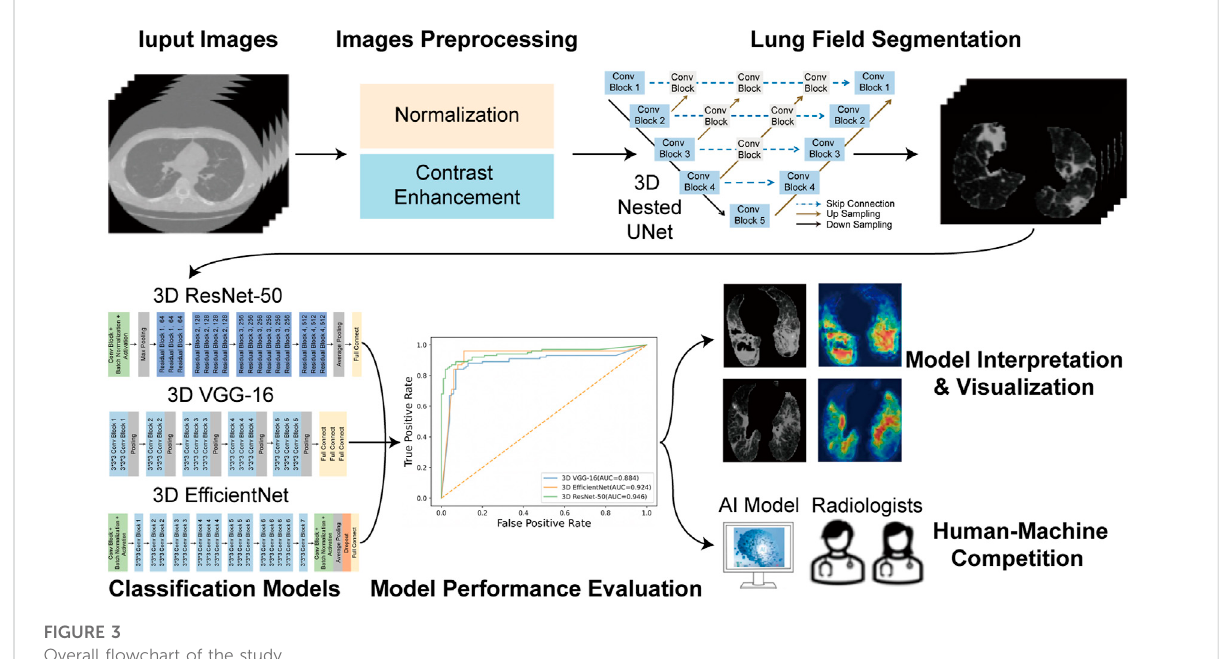
FIGURE 3 Overall fl owchart of the